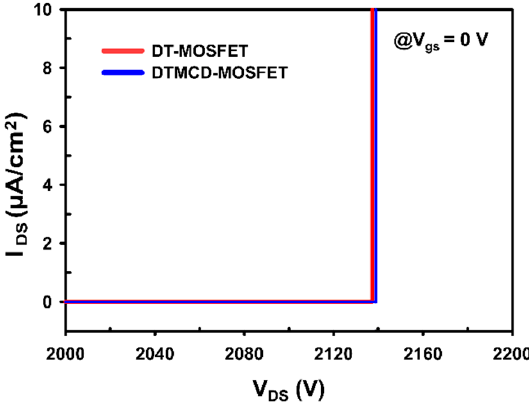
Figure 7. Comparison of off-state characteristics of DT-MOSFET and DTMCD-MOSFET.